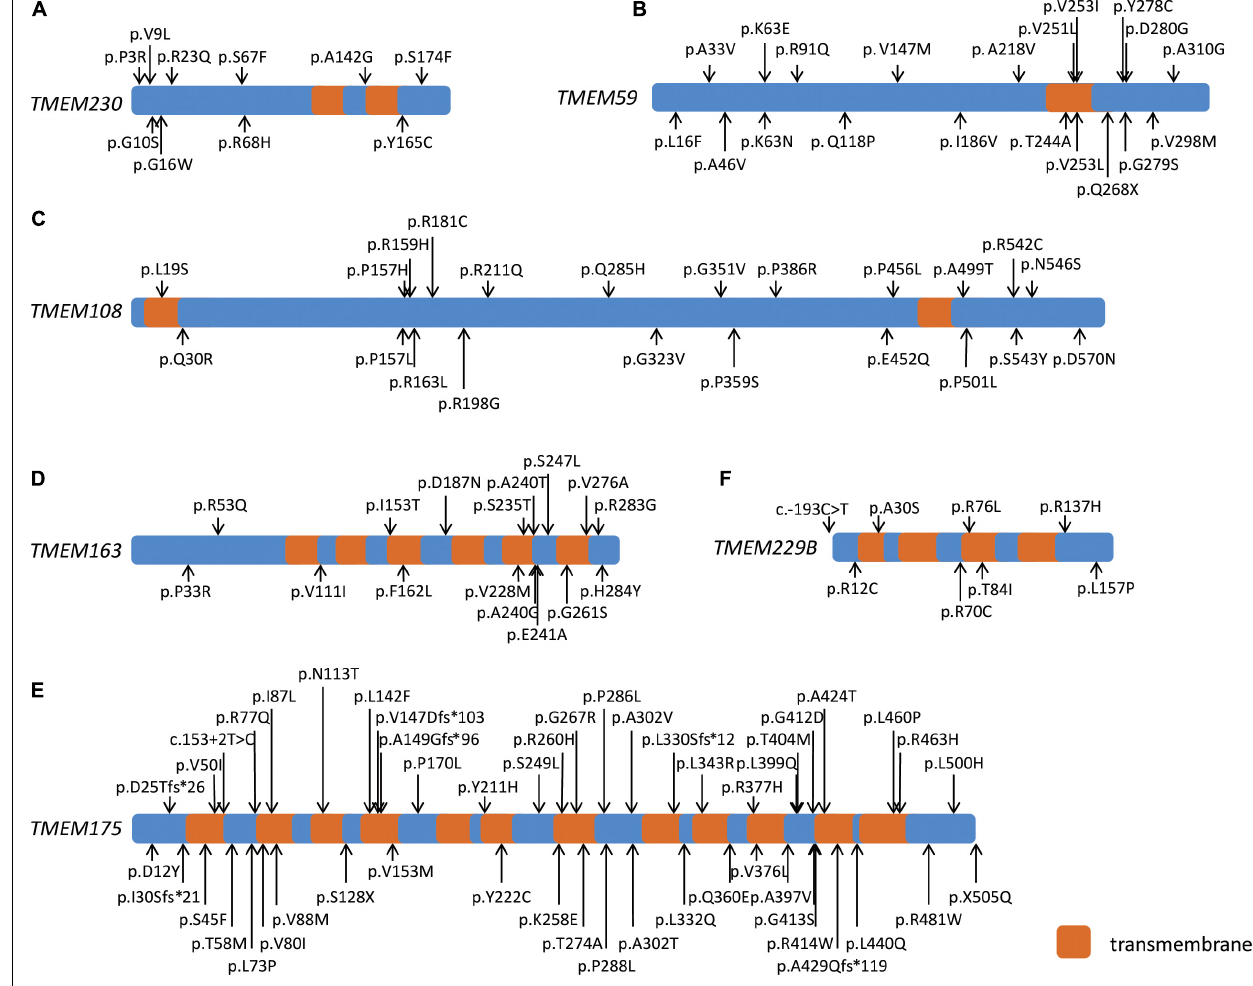
FIGURE 1 | Schematic diagram of six PD-related transmembrane (TMEM) protein family genes. Schematic diagram showing the transmembrane regions of six PD-related TMEM protein family genes and the rare damaging missense and loss-of-function variants of TMEM230 (A) , TMEM59 (B) , TMEM108 (C) , TMEM163 (D) , TMEM175 (E) , and TMEM229B (F) in both